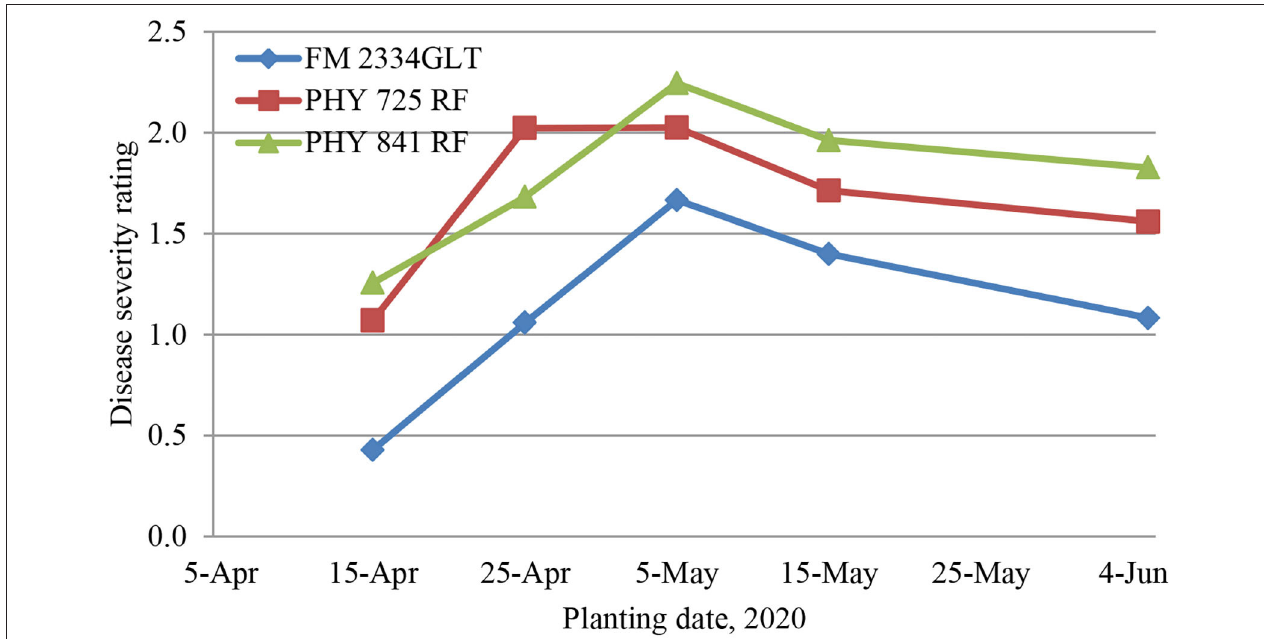
FIGURE 2 | Average disease severity rating in three cotton cultivars from five different planting dates (April 15, April 25, May 5, May 15, and June 5, 2020), 30 days post-artificial inoculation of Fusarium oxysporum f. sp. vasinfectum race 4. Individual plants were rated for disease severity based on the following scale: 0, no symptom; one wilted cotyledon; 2, two wilted cotyledons or two cotyledons abscised; 3, first true leaf wilted or three leaves abscised; 4, whole plant wilted or more than three leaves abscised; and 5, complete defoliation or plant death.